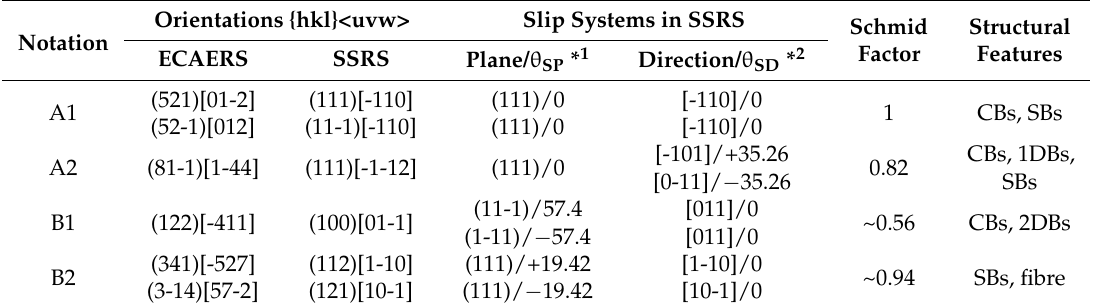
Table 1. A summary of the characteristic textures and associated microstructural features such as cell bands (CBs), primary deformation bands (1DBs) and secondary deformation bands (2DBs), and shear bands (SBs) and fibre structures (fibre) in both simple shear and ECAE reference systems x’y’z and xyz, including the related slip